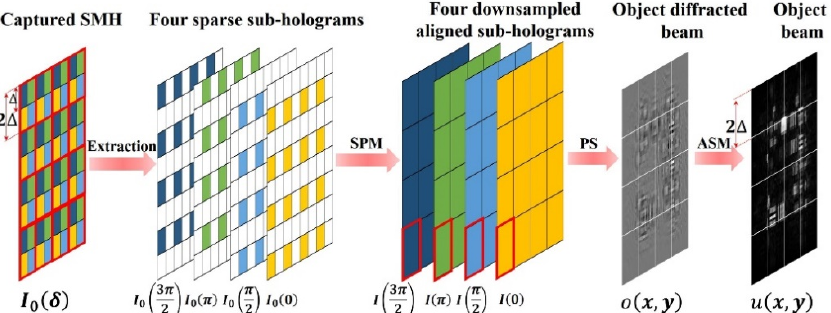
Figure 2. Conventional super-pixel method (SPM) calculation procedure of image reconstruction for PPSDH. SMH: spatially multiplexed hologram; PS: phase-shifting technique; ASM: angular spectrum method.